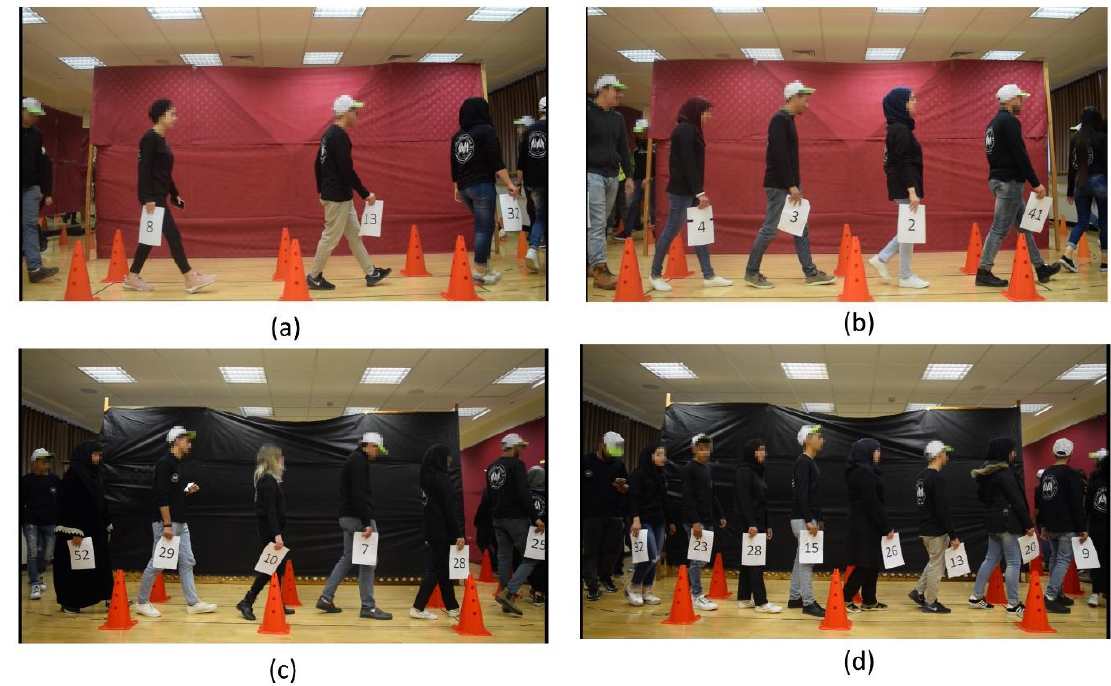
Figure 2. Snapshots taken during the experiment: ( a ) N = 14; ( b ) N = 20; ( c ) N = 24; ( d ) N = 30.